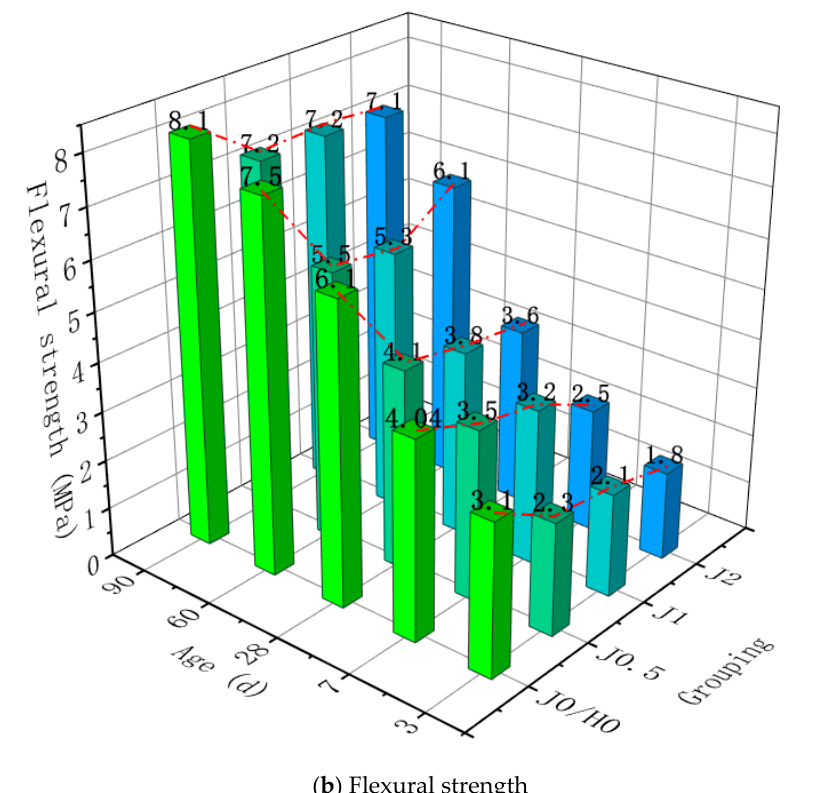
Figure 3. Effect of shrinkage-reducing agent on the compressive strength and flexural strength of concrete.